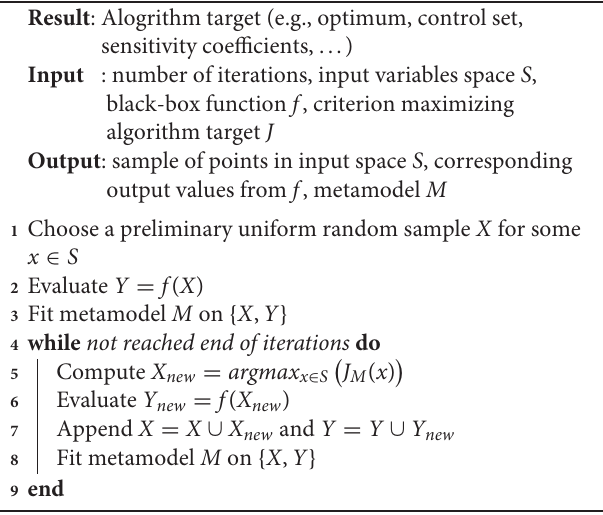
Algorithm 1: Sequential design of numerical experiments procedure based on J criterion of interest